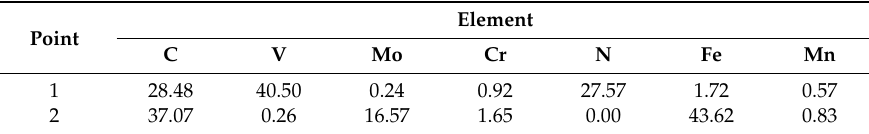
Table 6. The EDS results for precipitates (mass